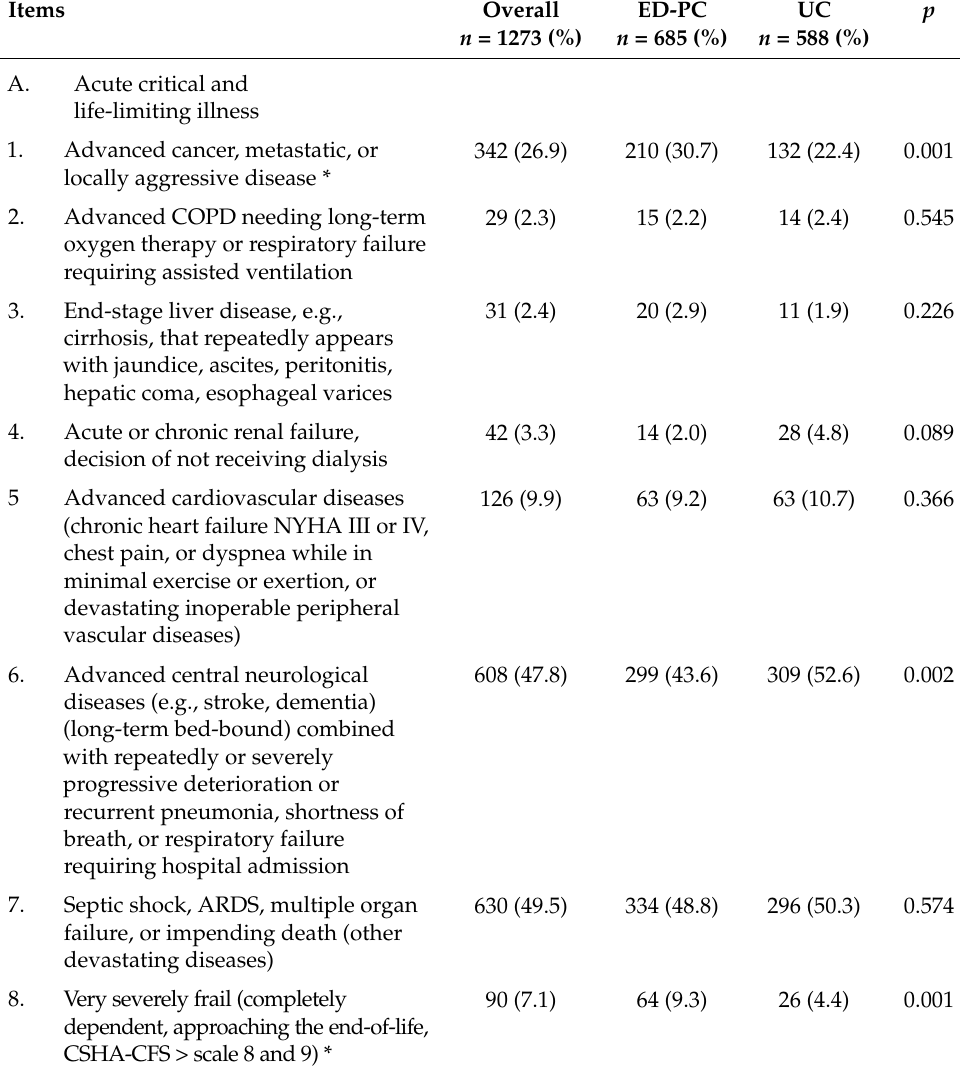
Table 1. The unmet needs assessment of 1273 patients with palliative care in the ED (ED-PC) and usual care (UC) at the time of